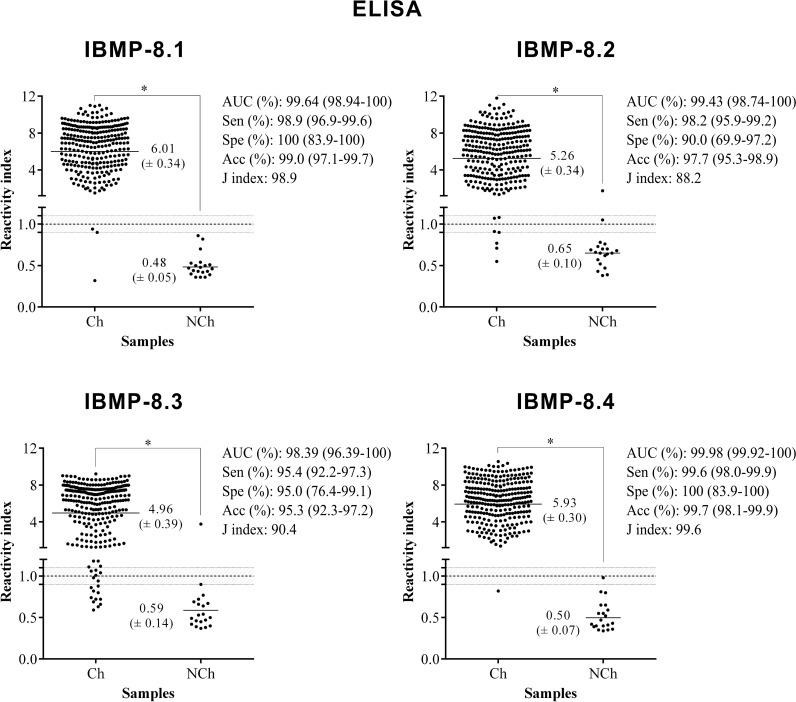
Anti-Trypanosoma cruzi IgG level in serum samples from chagasic (Ch) and non-chagasic (NCh) individuals assayed by ELISA.The cut-off value is 1.0 and shadowed area represents the grey-zone. Horizontal lines and numbers for each group of results represent the geometric means (± 95%CI).